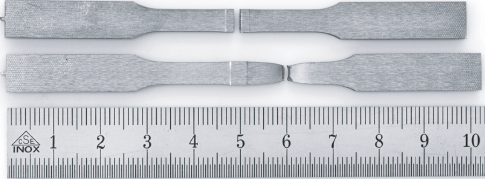
Figure 7. Fracture locations from the tested welded tensile specimens. Almost all tested tensile specimens break next to the weld seam, as shown below. Only, very weakly bonded specimens break in the bonding line, as shown above.